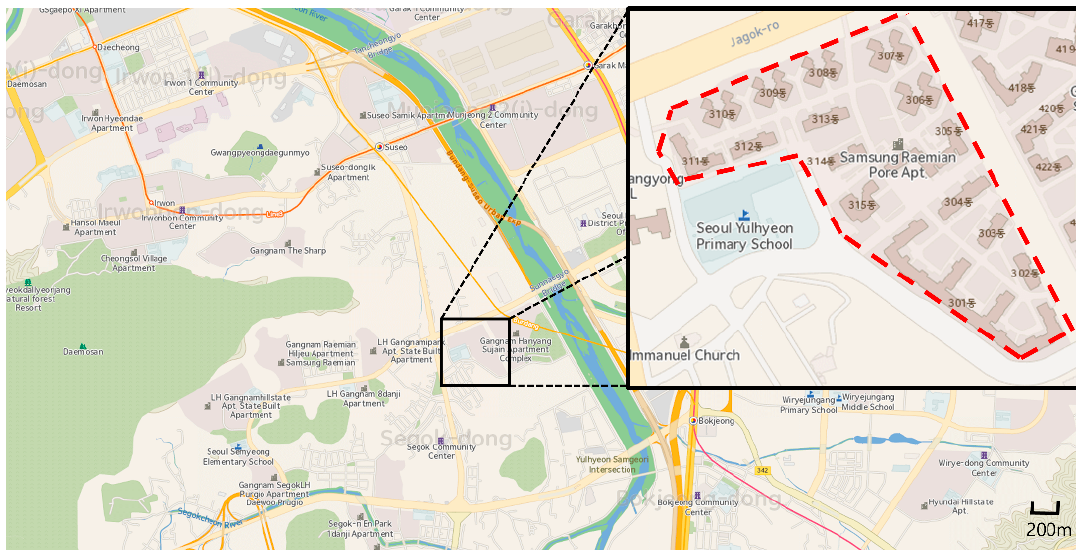
Figure 6. Local map of the considered apartment complex.